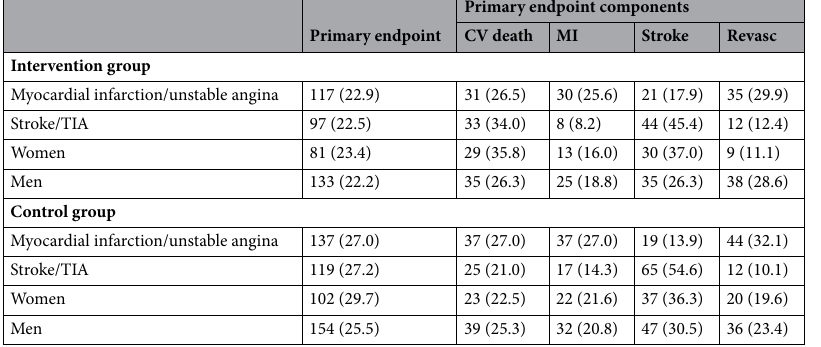
Table 3. Distribution of the primary endpoint and its components in subgroups defined by qualifying event and sex. Data are presented as N (%). CV death, Cardiovascular death; MI, Myocardial infarction; Revasc, Cardiac revascularisation; TIA, Transient ischemic